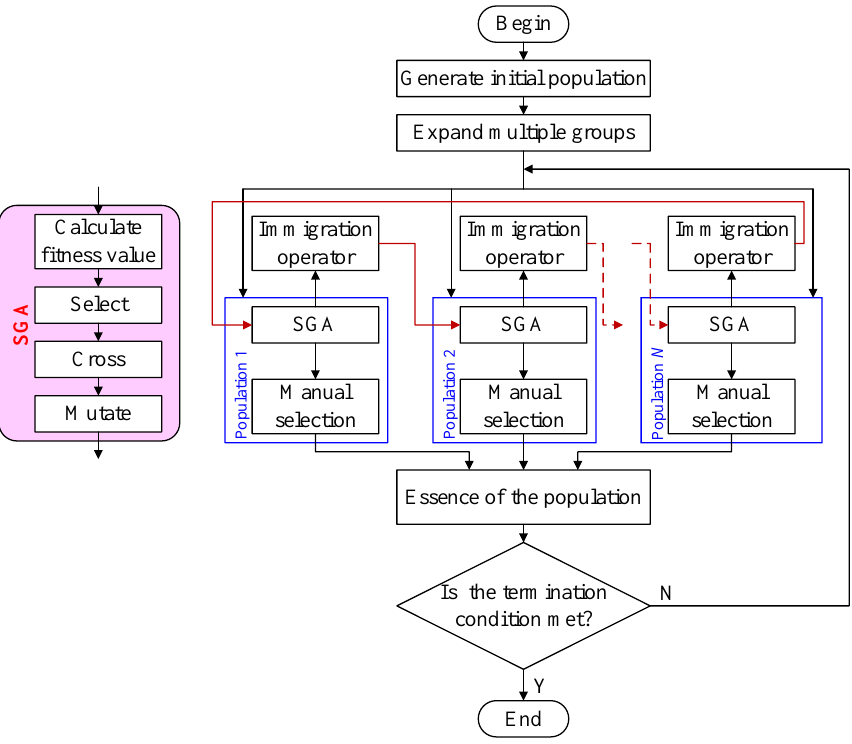
Figure 7. The optimization procedure of the MPGA.